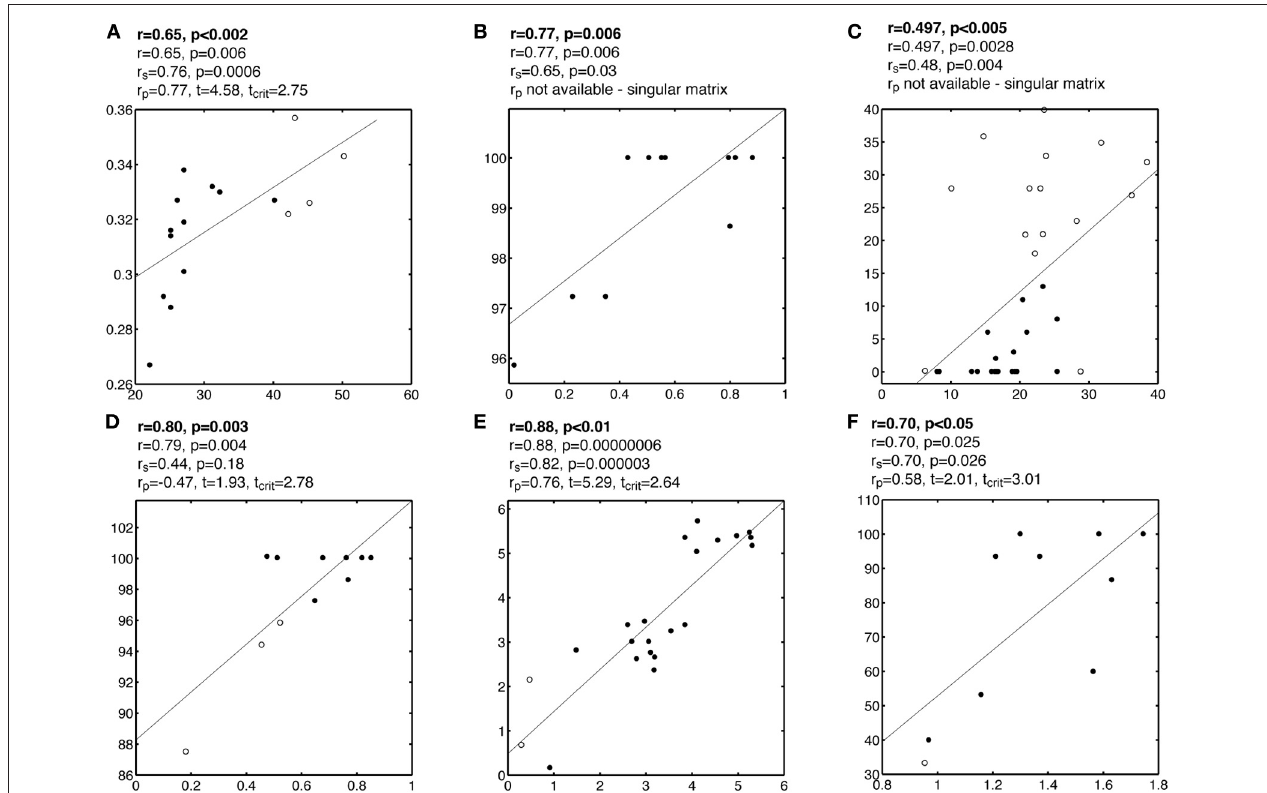
FIGURE A5 | Examples of false correlations potentially due to split data clouds. See Figure A1 caption for